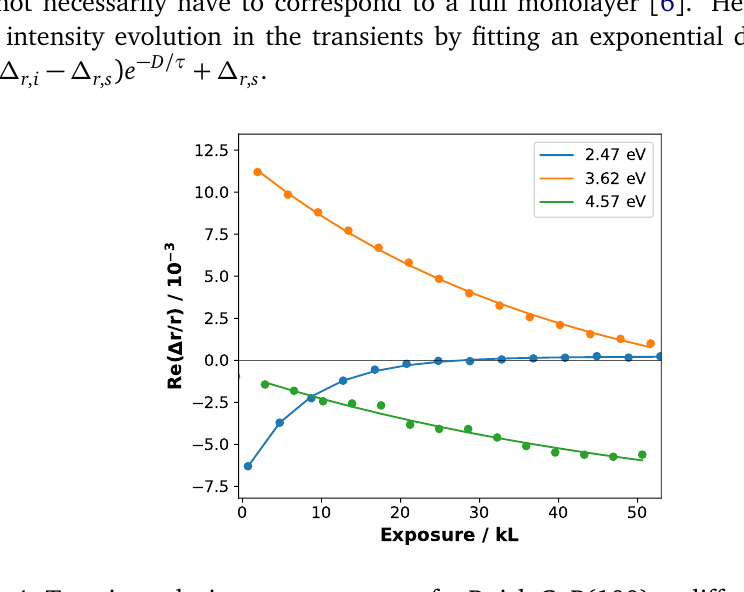
Figure 4: Transients during water exposure for P-rich GaP(100) at different energies. Dots represent data points, solid lines fits of a mono-exponential